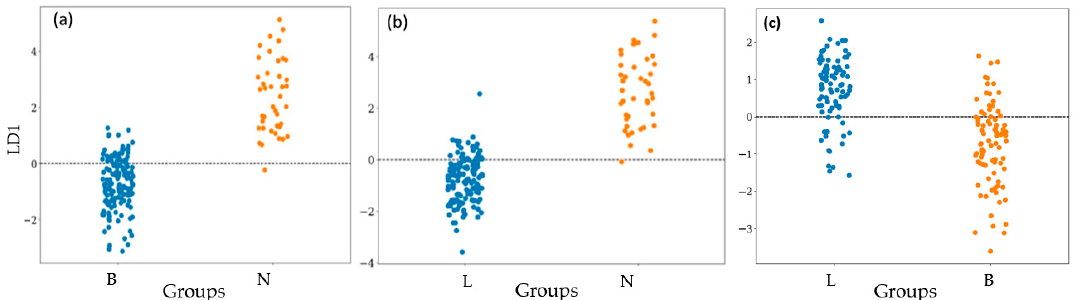
Figure 5. Classification of group N, B, and L after incubation for 48 h using linear discriminant analysis1 (LDA1). ( a ): N vs. B and ( b ): N vs. L, and ( c ) B vs. L.